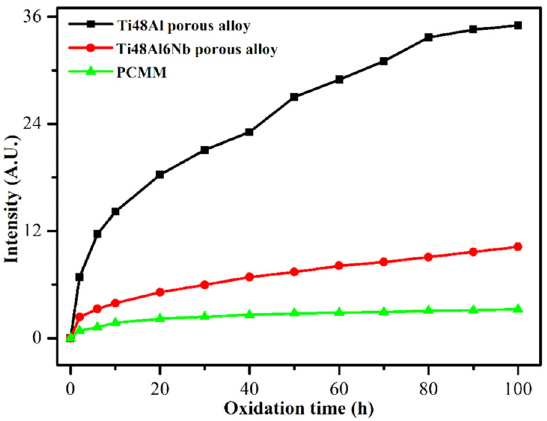
Fig. 7 Mass gain of porous sample at 900°C. Ti-48Al porous alloy (black), Ti-48Al-6Nb porous alloy (red), and PCMM with 4 wt.% Nano- ZrO 2 addition Fig. 9b and c. The PM concentration after fi ltration using Ti-48Al- 6Nb porous alloy or PCMM fi ltration is much lower than the concentration before fi ltration in both cases (Fig. 9d). For PM with sizes >2.5 μ m, the removal ef fi ciency does not vary signi fi cantly for Ti-48Al-6Nb porous alloy or PCMM, although the separation ef fi ciencies can be enhanced to 99.58% and 99.98% from 97.38% and 97.89% for PM 2.5 – 5 and PM 5 – 10 , respectively. However, for PM with sizes <2.5 μ m, the removal ef fi ciency of PCMM is found to be greatly increased to 99.23%, 98.51%, 91.36% and 79.66% from 85.03%, 43.54%, 23.63% and